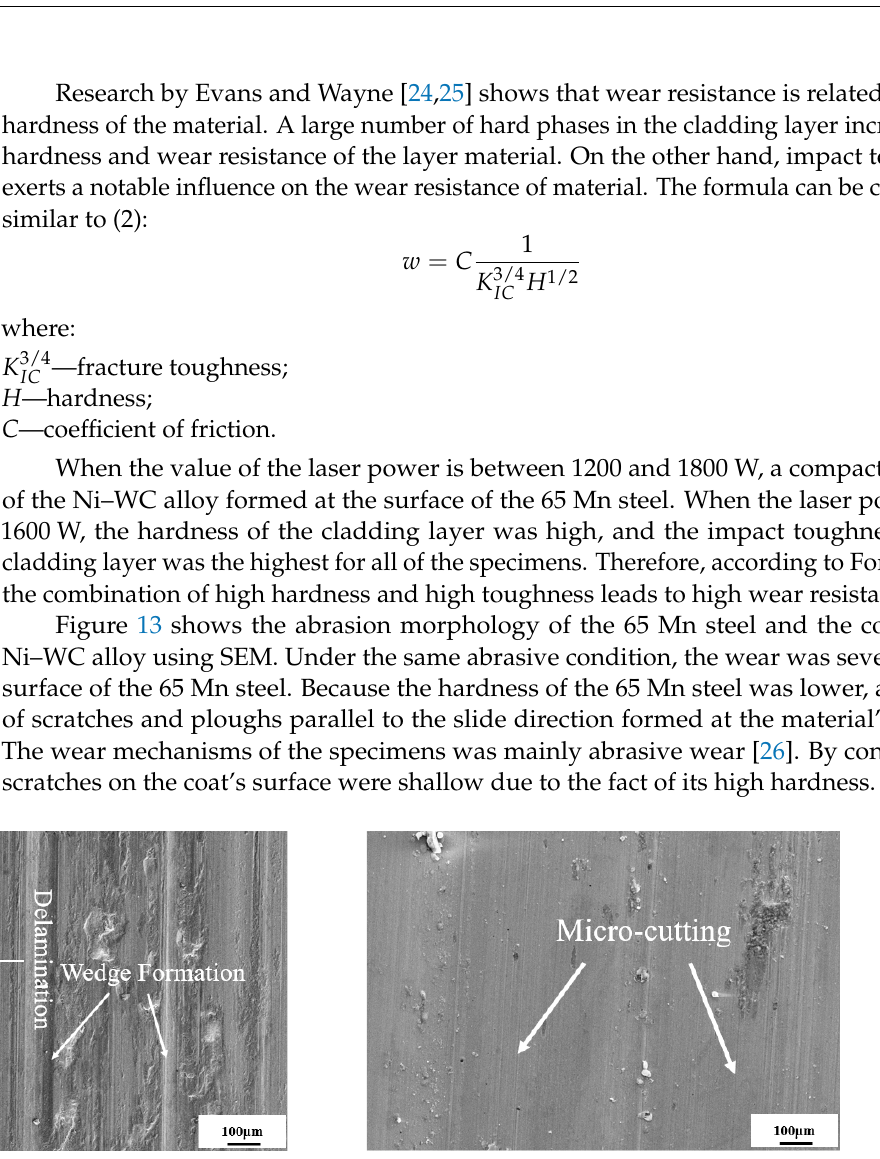
Figure 14. Macro-morphology of the two blades after working on the harvester for 43 h of operation: ( a ) knife with 1600 W laser cladding; ( b ) 65 Mn cutting tools available on the market. Laser cladding self-grinding knives and knives without cladding were assembled on the same lawn mower. With the same working condition, the mass loss of the tested knives were recorded and are shown in Figure 15.